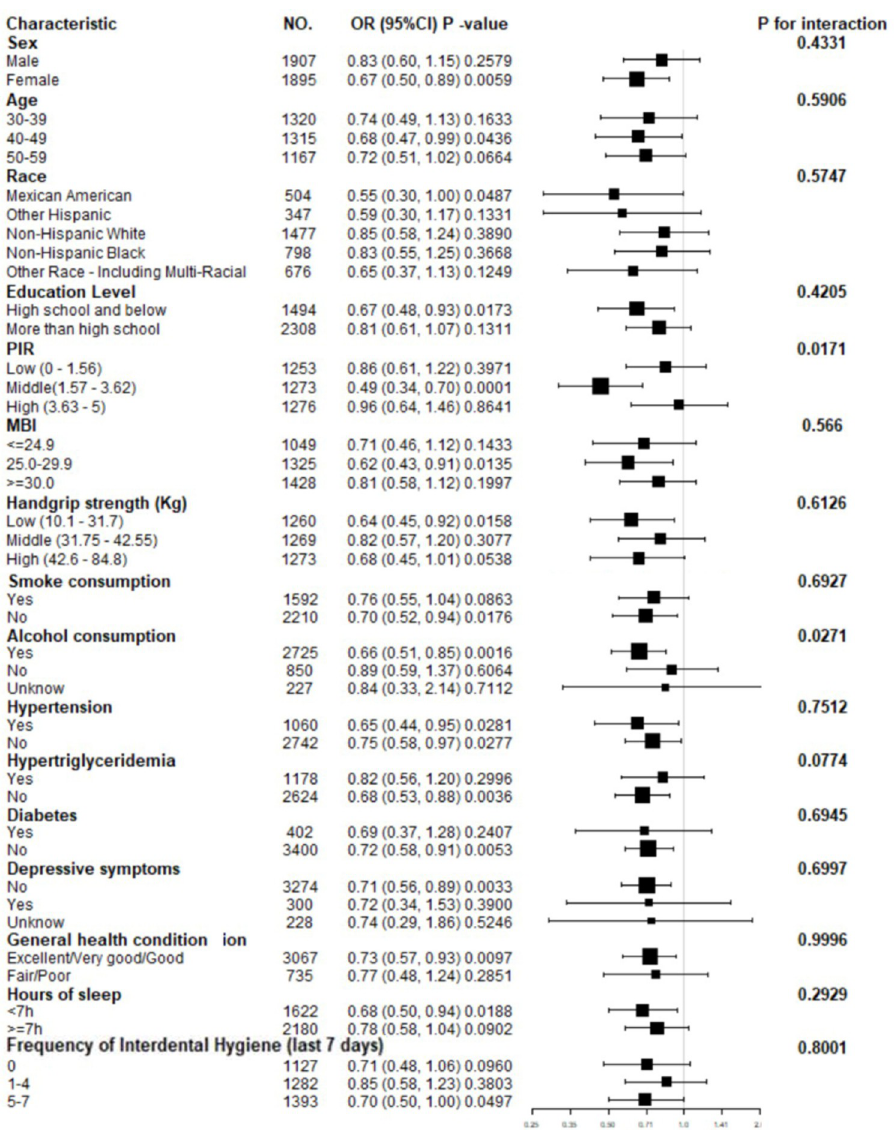
Fig 2. Forest map-Subgroup analyses of the effect of skull BMD on periodontitis � . Abbreviations: PIR, poverty income ratio. BMI, body mass index. CI, confidence interval. OR, odds ratio. � Adjusted for sex, age, race, education level, PIR, BMI, handgrip strength, smoke consumption, alcohol consumption, hypertension, hypertriglyceridemia, diabetes, depressive symptoms, general health condition, hours of sleep, frequency of interdental hygiene (last 7 days) except the subgroup